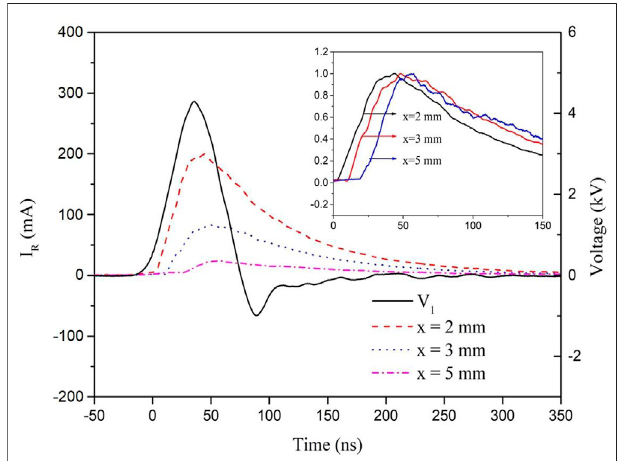
FIGURE 4 | Current waveform of the grounded resistance. The resistance is 10 k Ω . V 1 is the voltage of the supply. I R is the current on the groundingresistance.xisthedistancebetweenthegroundresistancepinand thenozzleoutlet.Thesmallgraphintheupperrightcornerisobtainedby normalizing the waveform of I R with x = 2 mm, x = 3 mm, and x = 5